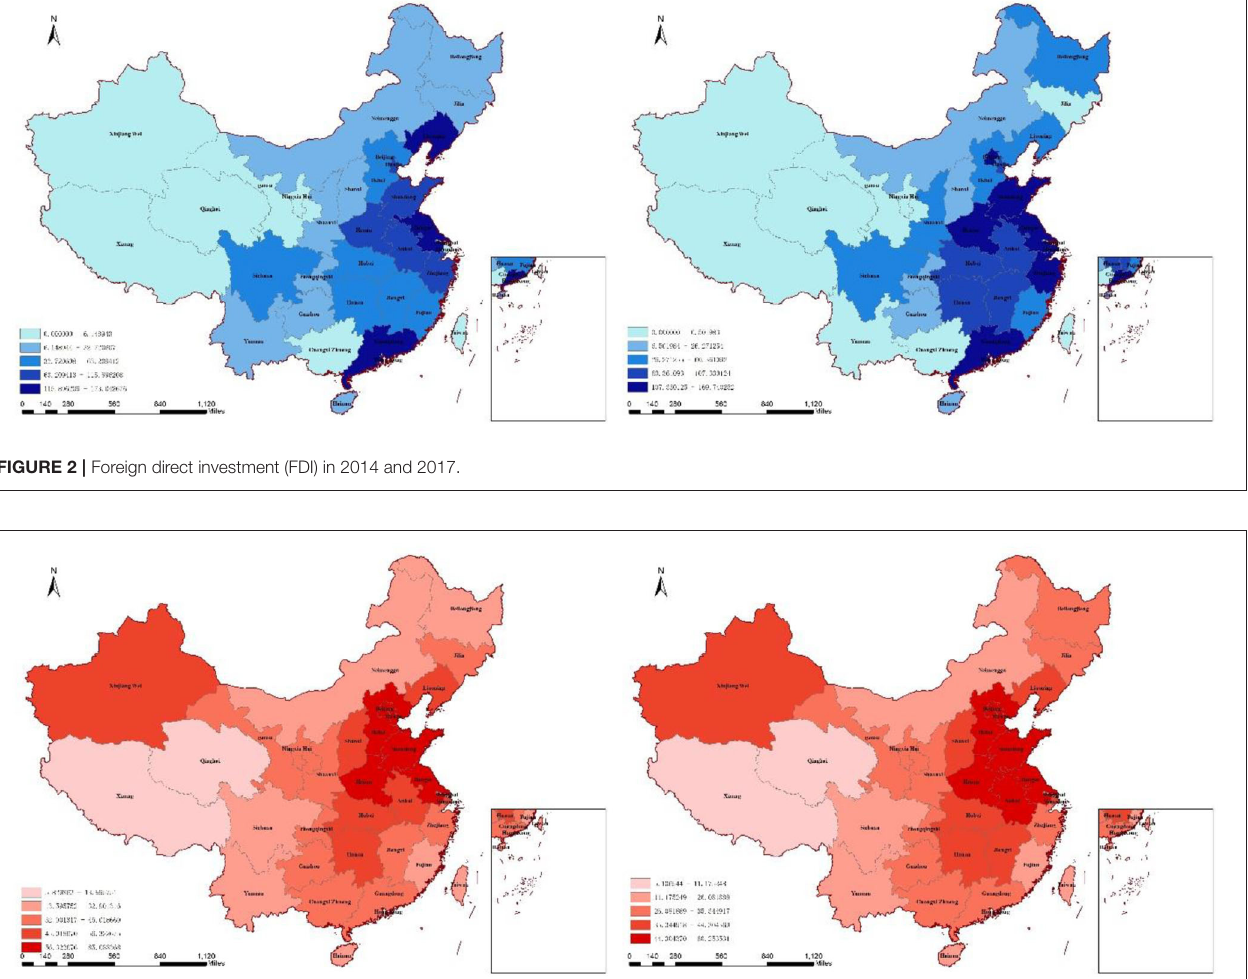
FIGURE 3 | The concentration of PM 2.5 in 2014 and